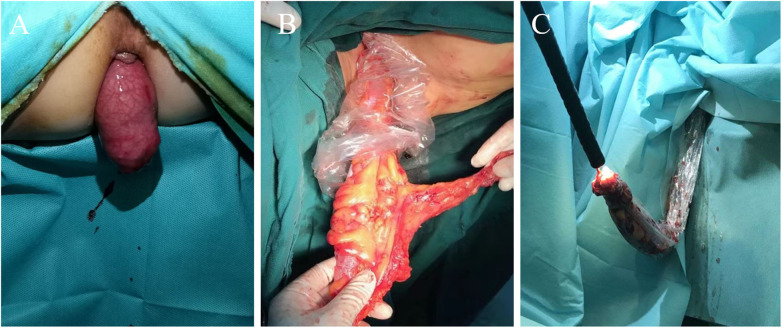
Three methods for extraction specimens. (A) Transanal specimen eversion and extra-abdominal resection technique. (B) Transluminal specimen extraction and extra-abdominal resection technique. (C) Intra-abdominal specimen resection and transluminal extraction technique.